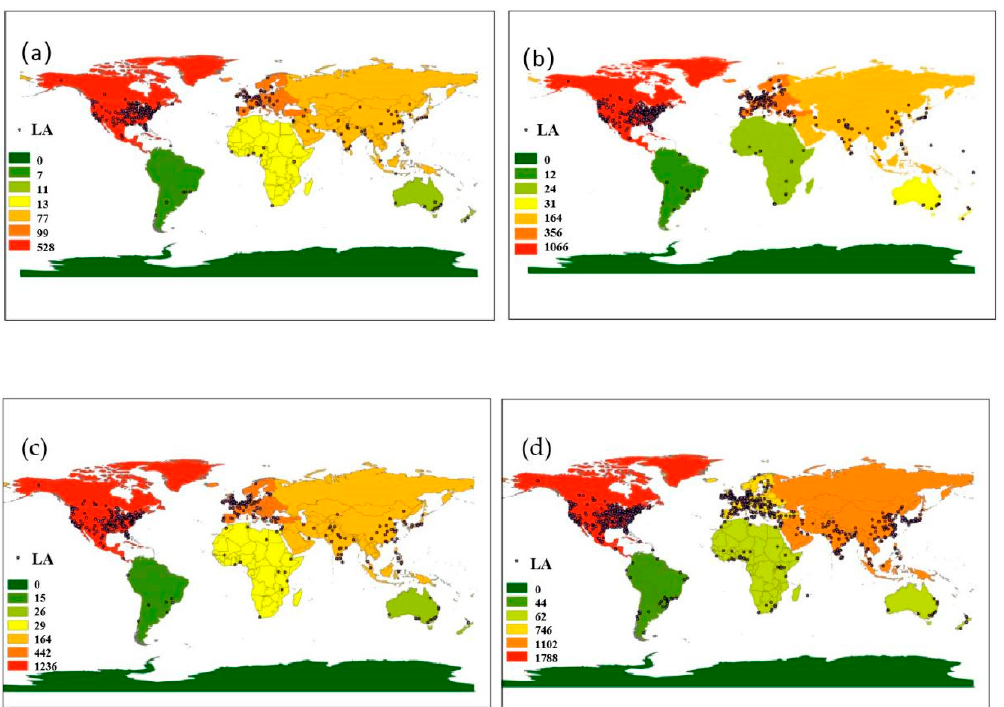
Figure 2. Global geographical distribution of authors based on institution location during ( a ) 1991 to 1997; ( b ) 1998 to 2003; ( c ) 2004 to 2009; and ( d ) 2010 to 2015. Color shades represent the number of articles, and the intensity of spots represents geographic distribution of authors. LA: Location of authors